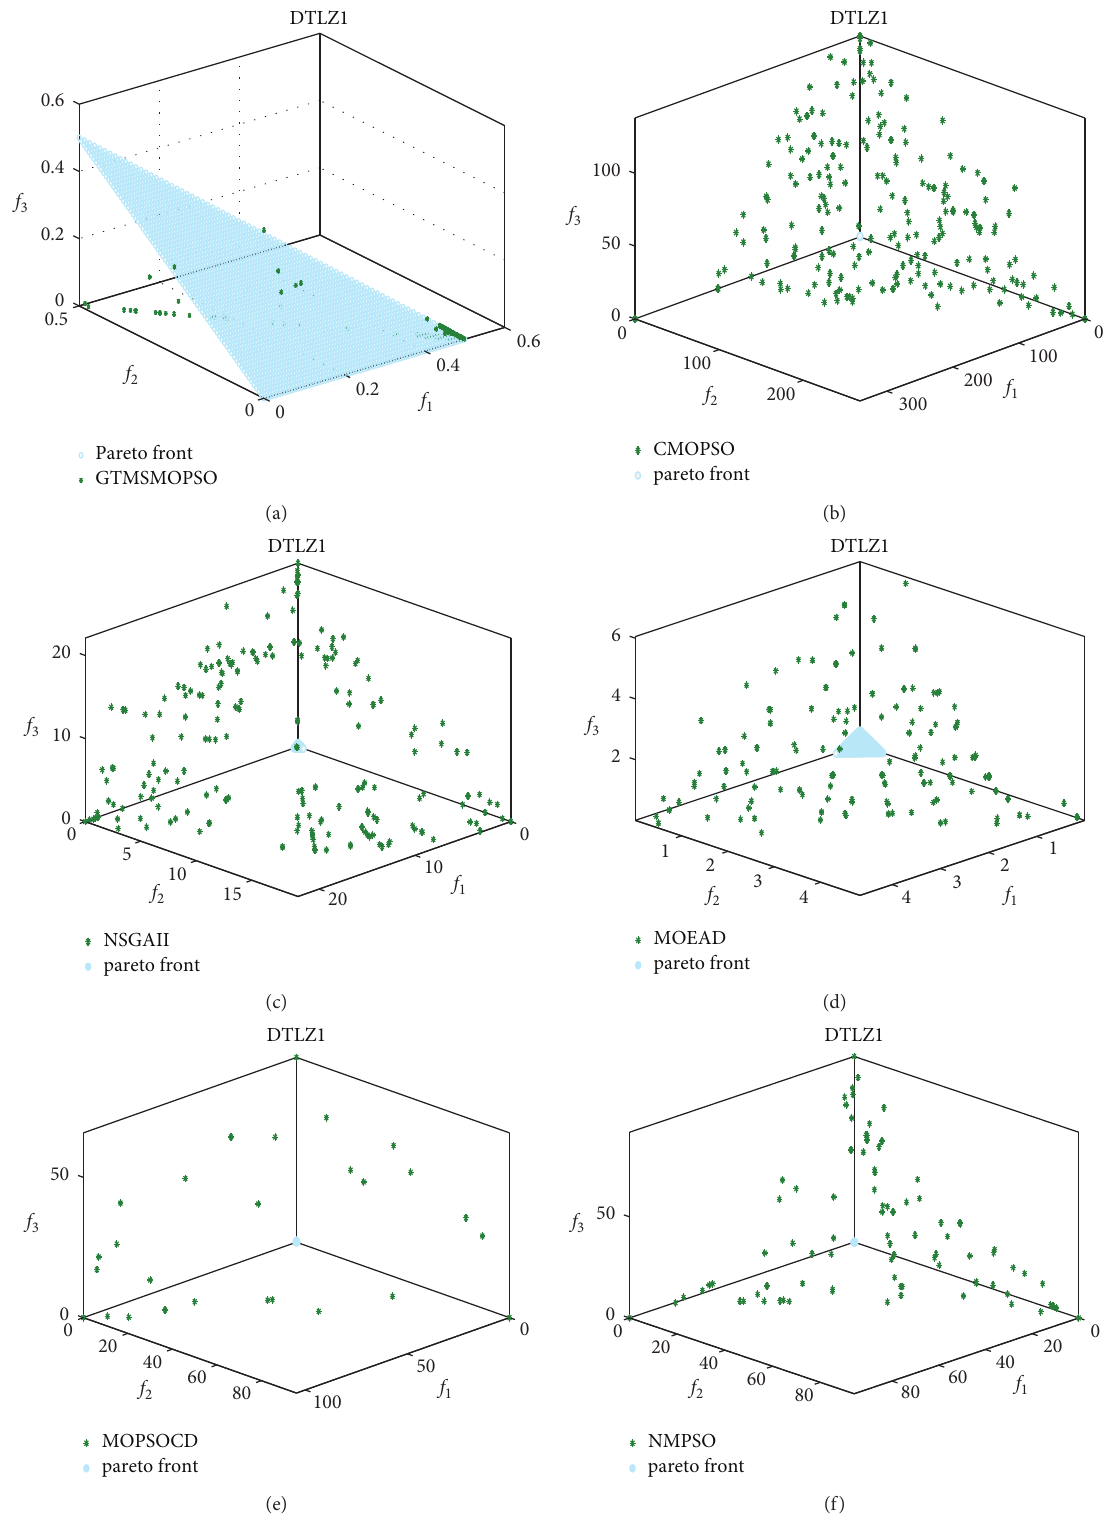
Figure 8: Pareto frontier effect of three different algorithms for DTLZ1